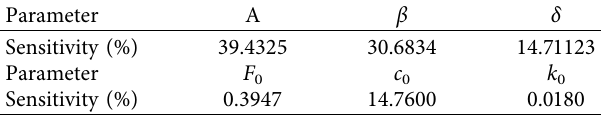
Table 3: The sensitivity results from the neural network model. Parameter